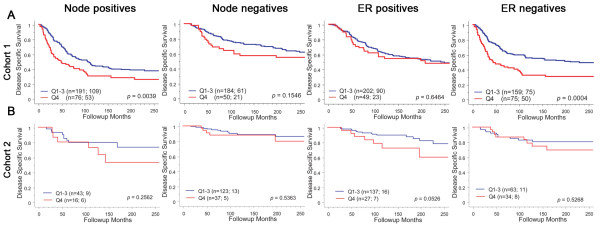
Kaplan-Meier analysis for Menacalc in sub-populations based on nodal status and ER status in two primary breast cancer cohorts. Each cohort was divided into quartiles and disease specific survival of the highest quartile of expression was compared to the remaining patient population. The number of patients in each group is shown followed by the number of patient deaths due to disease. Log-rank P-values are shown for 20-year follow-up. Only Menacalc scores in node positive and ER negative sub-populations are statistically significant in cohort 1 (P = 0.0039 and 0.0004 respectively).